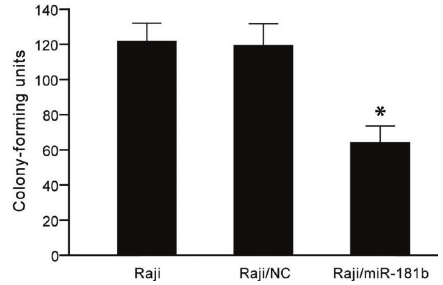
Figure 8. FAMLF down-regulation by miR-181b signi fi cantly reduced the colony-formation ability of Raji cells. Colony-forming units were decreased from 119 to 64 after transfection of miR- 181b. *P o 0.01, Raji/miR-181b compared to Raji and Raji/NC (ANOVA). Data are reported as means ± SD Figure 7 . Flow cytometry analysis showing the Raji cell cycle distribution after 24 and 48 h of trans- fection. The percentage of cells was increased in G0/G1 phase (58.98 – 72.94%) and was reduced in G2/M and S phase after transfection of miR-181b. P o 0.05, Raji/miR-181b compared to Raji and Raji/ NC (ANOVA). NC: normalized control. Data are reported as means (n=6).